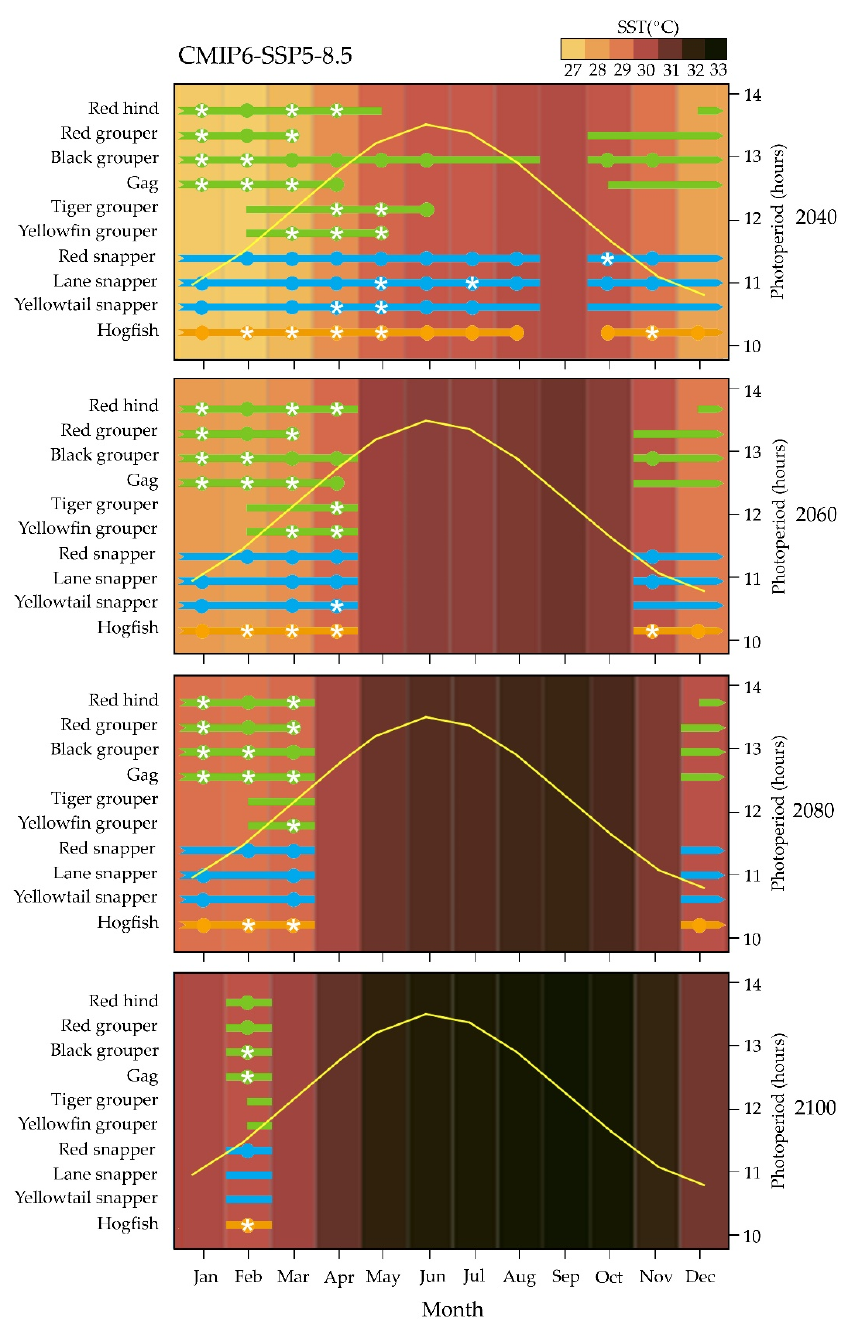
Figure 4. Hypothetical effect of climate change on reproductive cycle of studied grouper (green bars), snapper (blue bars), and wrasse (orange bars) species from the Campeche Bank, in relation to 2040, 2060, 2080, and 2100 monthly changes in mean sea surface water temperature (SST) predicted by the CMIP6 SSP5-8.5 scenario of the Intergovernmental Panel on Climate change [46–48]. For each species, solid bars represent reproductive season reported as the months that include spawning capable females; solid circles represent spawning season reported as the months that include actively spawning females, and white stars represent peak spawning reported as the months that include more than 50% of females in actively spawning sub (for reproductive phase terminology see [49]). Yellow curve indicates monthly photoperiod length (Time and Date AS 1995–2022. Available online: http://www.timeanddate.com/sun/mexico/merida, accessed on 1 March